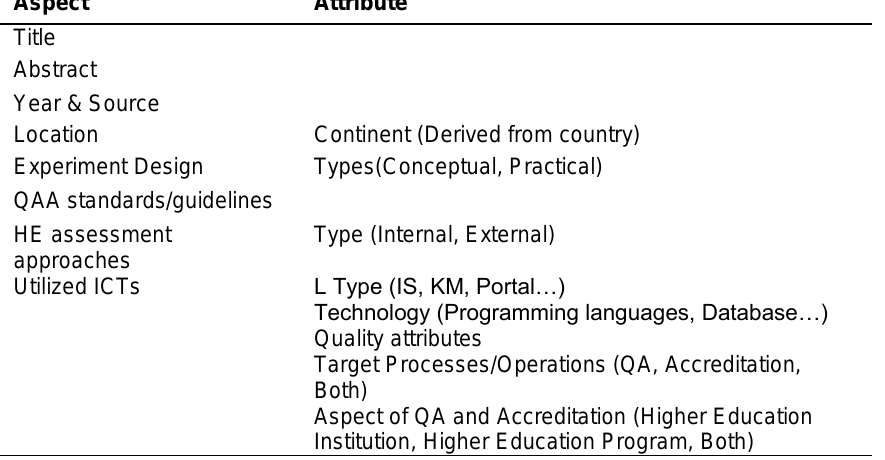
Table 1. Data Extraction